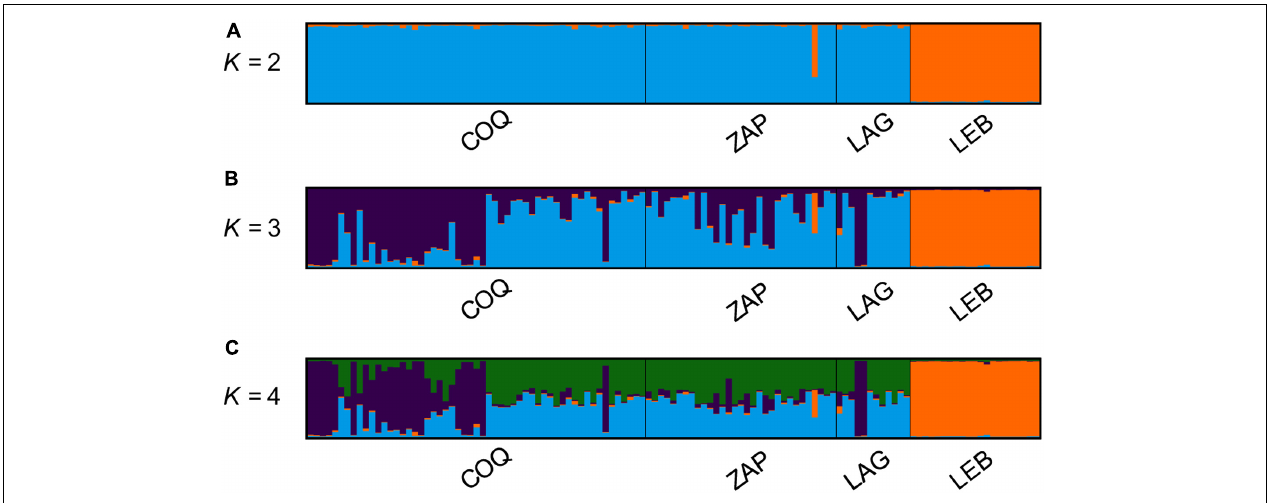
FIGURE 4 | Bayesian analyses of population structure performed with STRUCTURE. Each vertical bar represents one individual, and the color proportion for each bar represents the posterior probability of assignment of each individual to the different groups ( K ) inferred. (A) At K = 2 LEB individuals formed a clear separate group from the other locations. (B) At K = 3, LEB individuals were grouped together in group I with a 98.5% average proportion of membership ( Table 6 ), COQ was also grouped separately in group II, while LAG and ZAP were grouped together in group III. (C) No further changes were observed with K > 4.